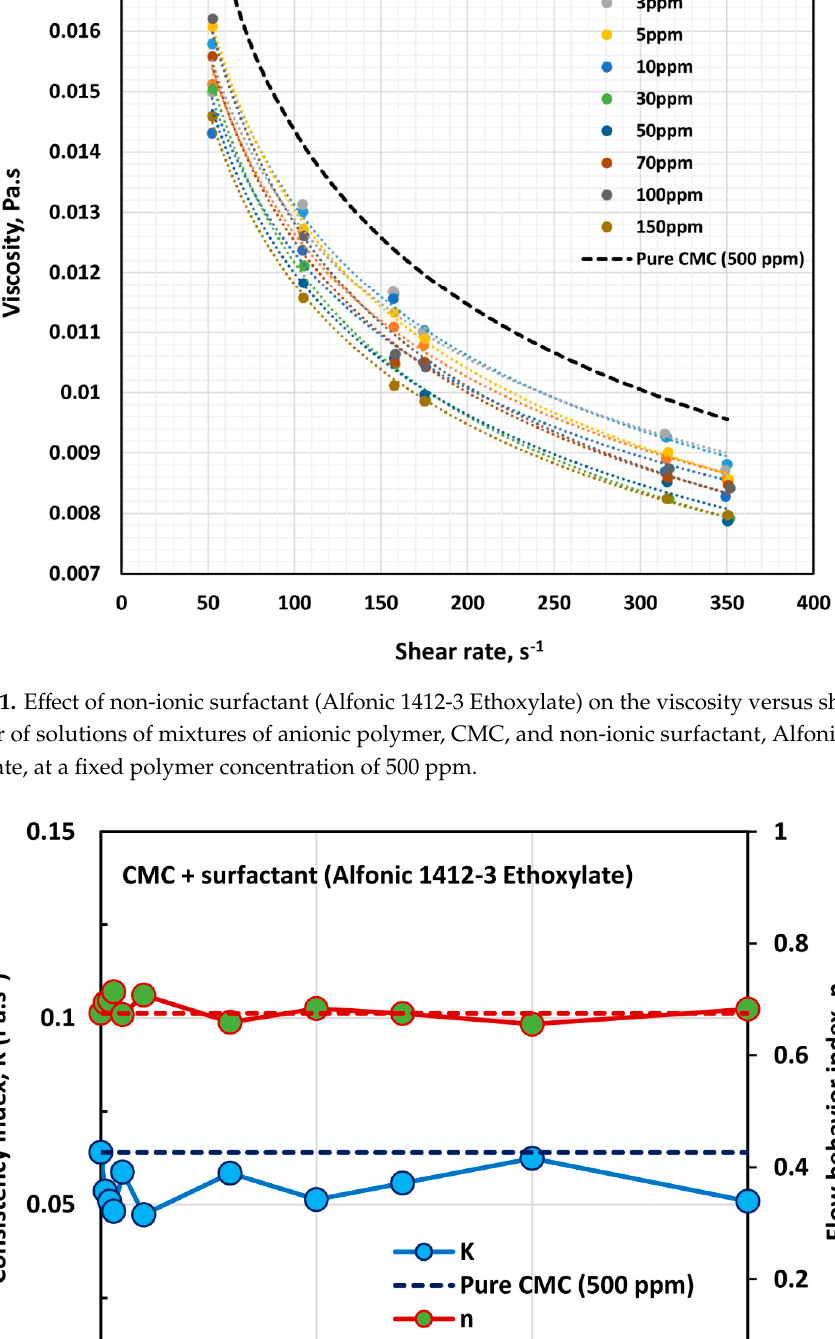
Figure 13. Variation of surface tension of surfactant-polymer solutions with the increase in surfactant (Alfonic 1412-3 Ethoxylate) concentration, at a fixed polymer (CMC) concentration of 500 ppm. 3.5. Effect of Non-ionic Surfactant (Aromox DMC) on the Rheological Behavior and Surface Activity of Solutions of Anionic Polymer CMC Figure 14 shows the influence of non-ionic surfactant Aromox DMC (Dimethylcocoalkylamine oxide) on the viscosity of anionic polymer (CMC) solutions at a fixed polymer concentration of 500 ppm. The solutions are shear thinning and the flow curves are nearly parallel to each other.